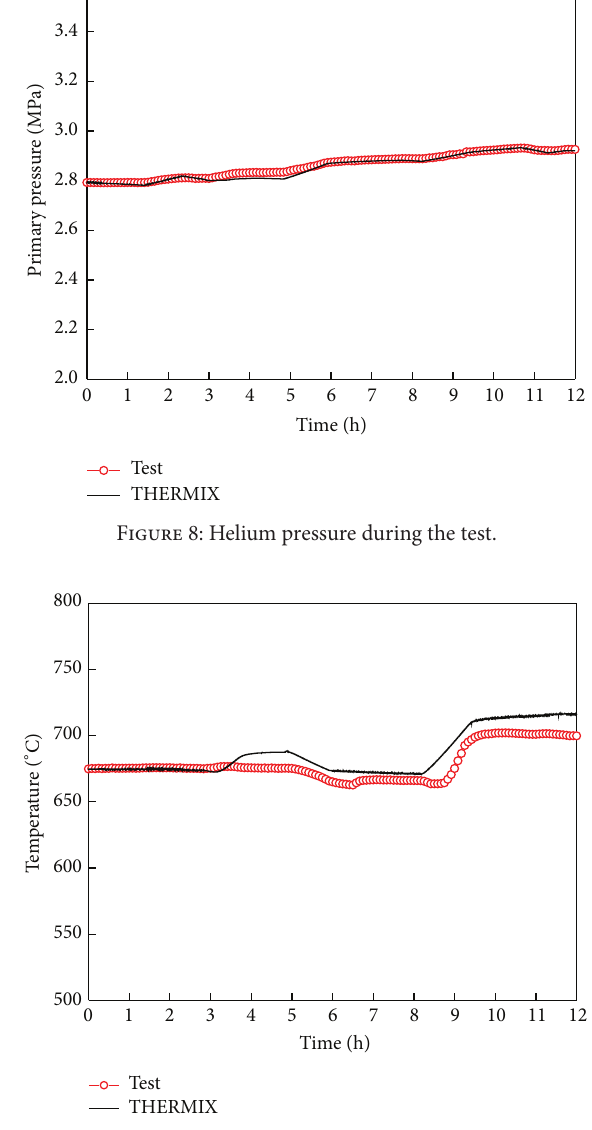
Figure 9: Helium outlet temperature during the